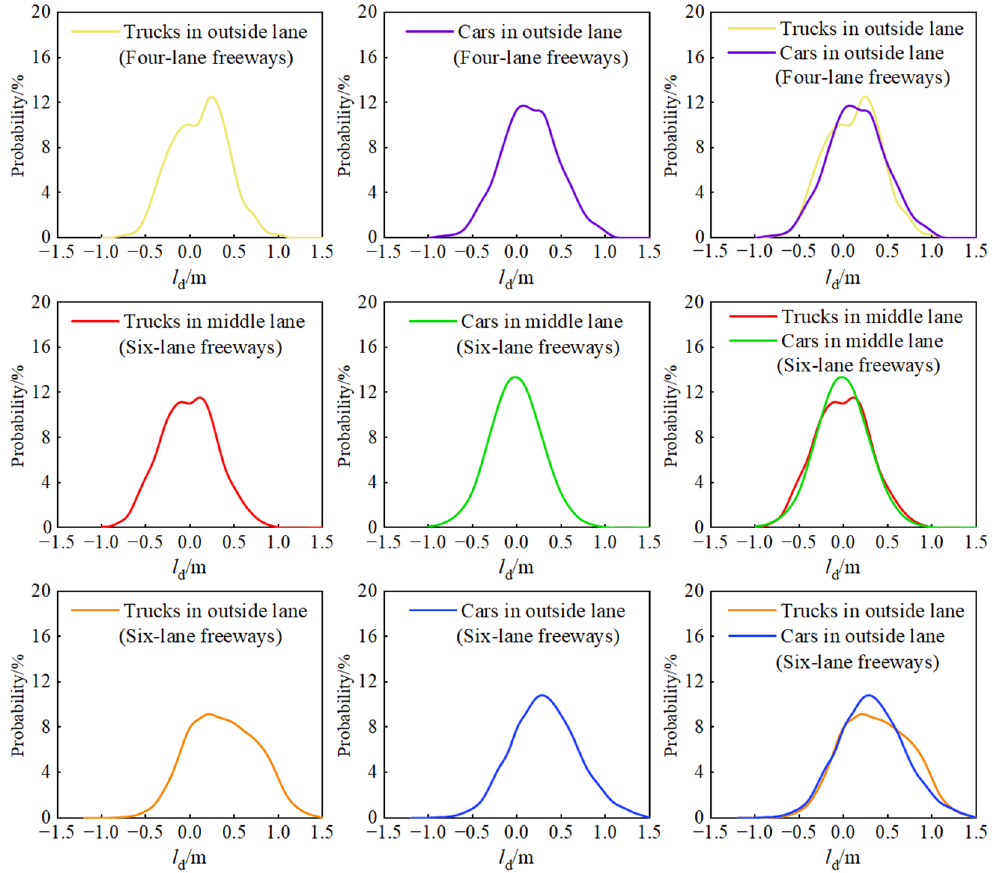
Figure 13. Distribution of trajectory deviation of different vehicle types. Table 4. Statistical characteristic value of preferred trajectory deviation for different vehicle types.